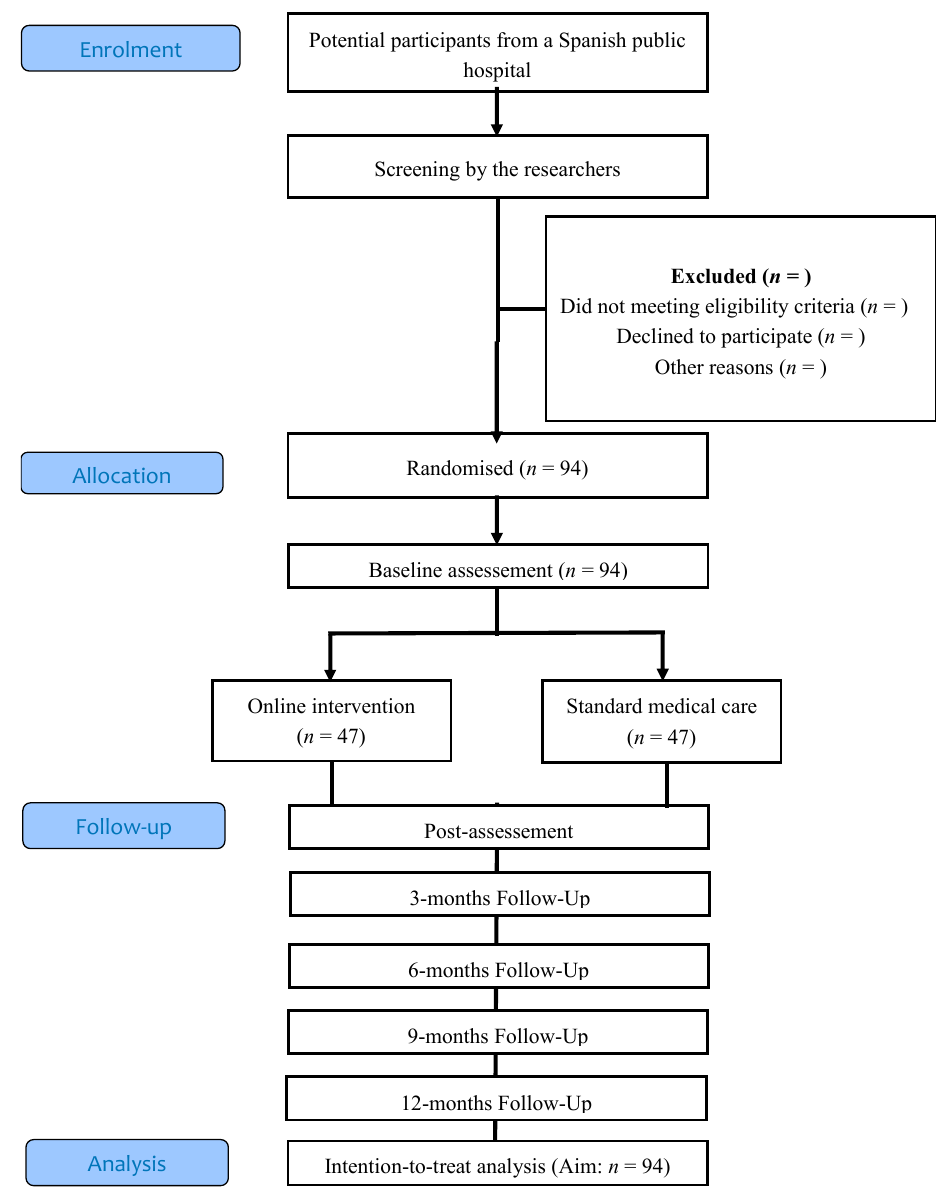
Figure 1. Flowchart of the study design.